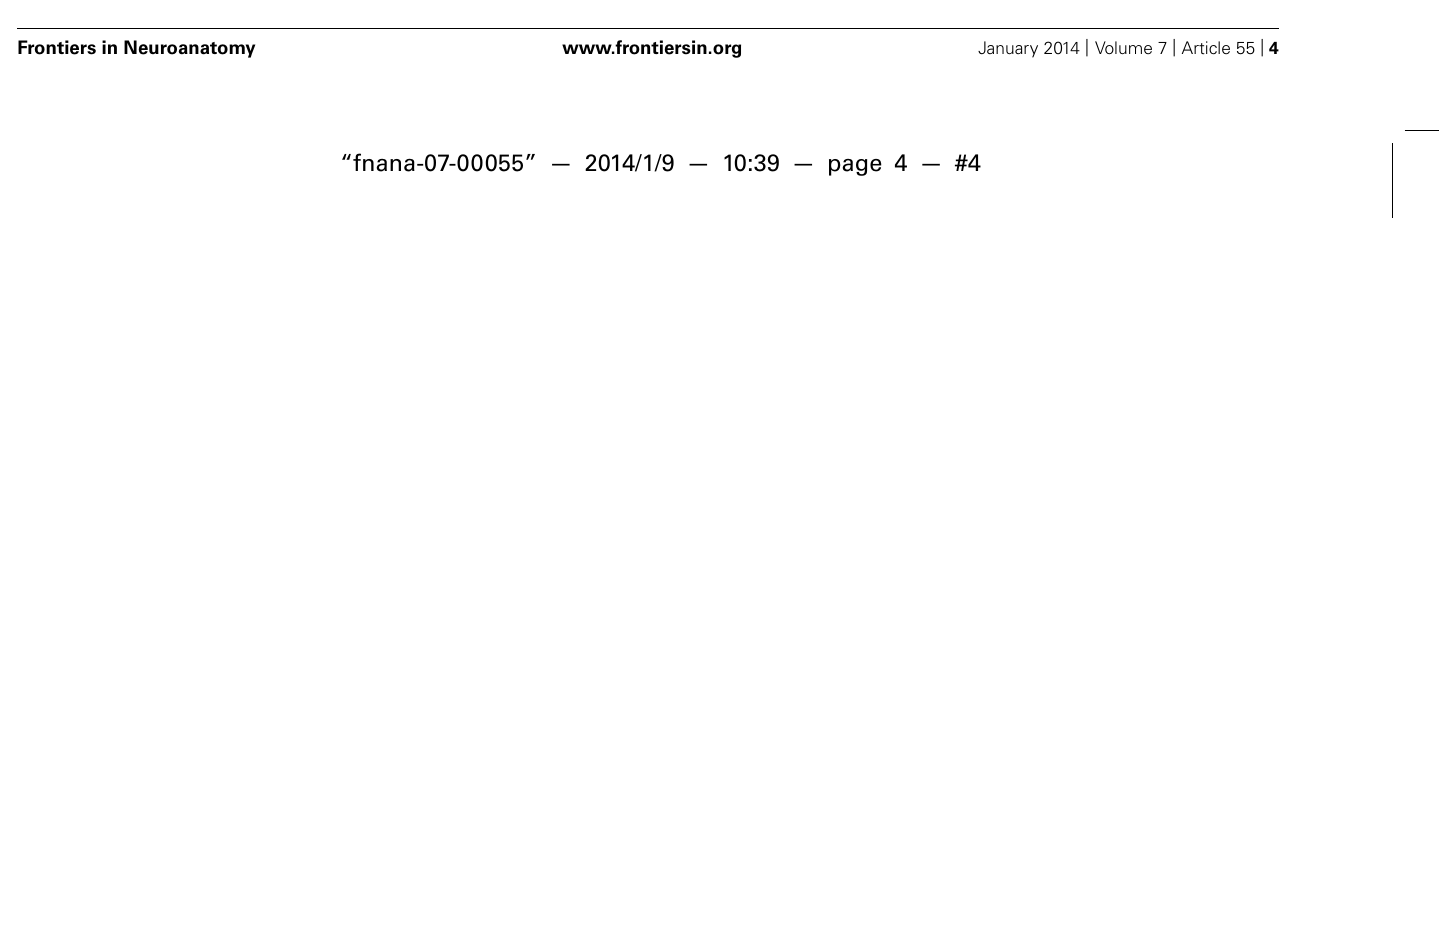
injection into the right SC (cid:3) are found in both the piMRF (A,B) and cMRF (C,D) , as well as in the cuneiform nucleus (E,F) . Doubly labeled neurons ( were most common in the piMRF (A,B)